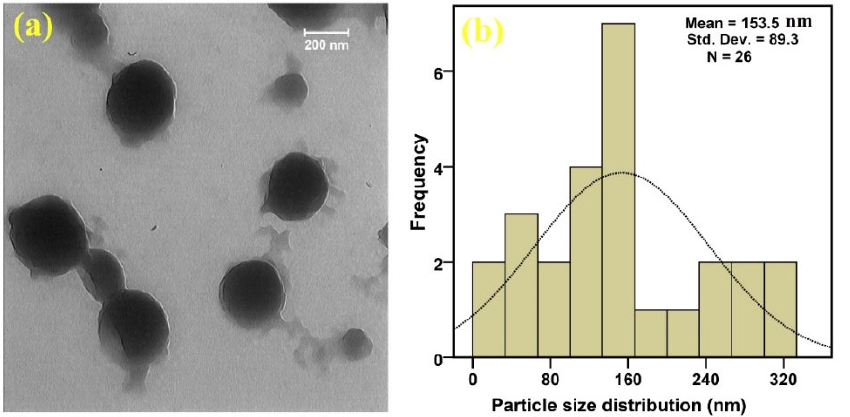
Figure 1. ( a ) TEM image, ( b ) size distribution of cinnamon NPs.